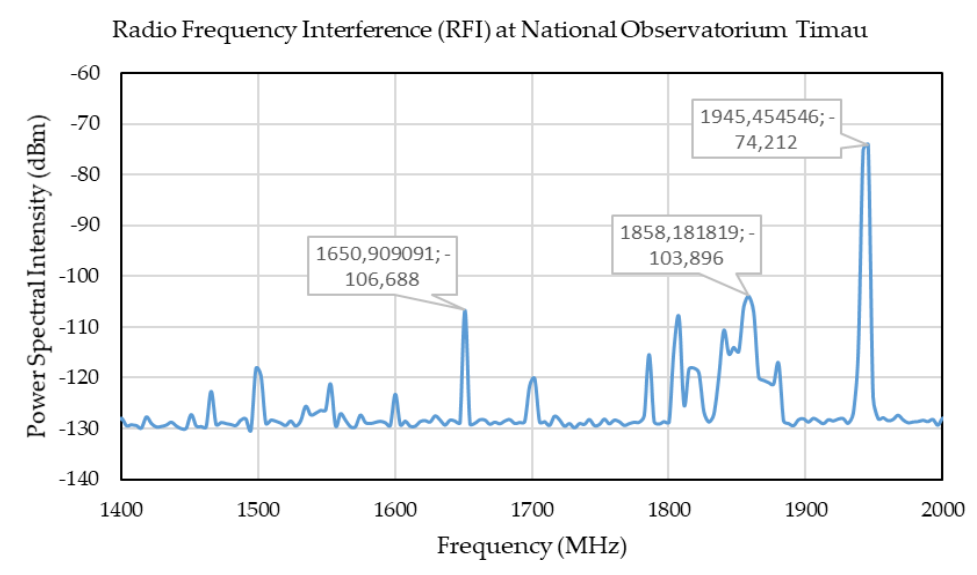
Figure 8. Results of radio frequency survey at low frequencies between 1400 and 2000 MHz.